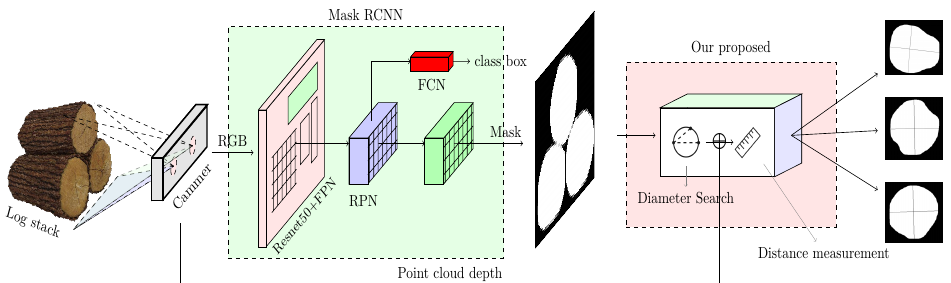
Figure 4. Processes of the wood